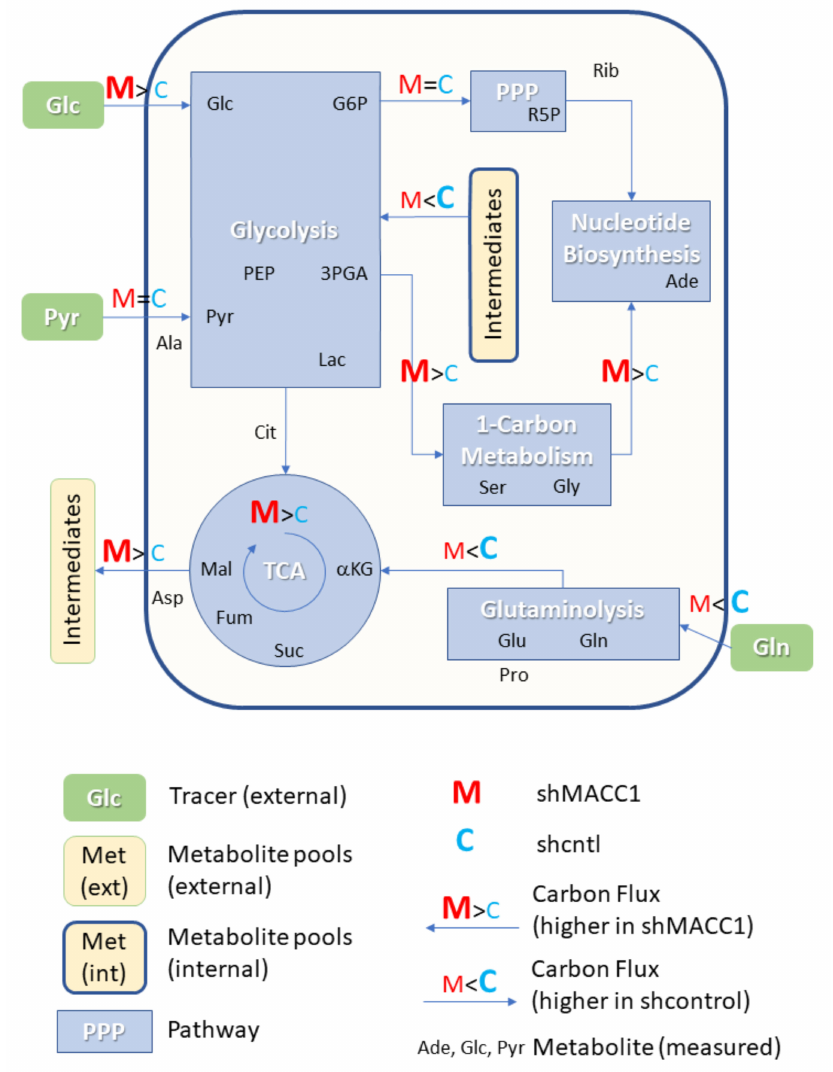
Figure 6. MACC1 dependent effects on cellular pathways. Overview of cellular pathways where MACC1 dependent effects could be monitored due to detectable differences in 13 C tracer incor- poration. Evidence for the depicted differences is provided in Figure 7 and the manuscript